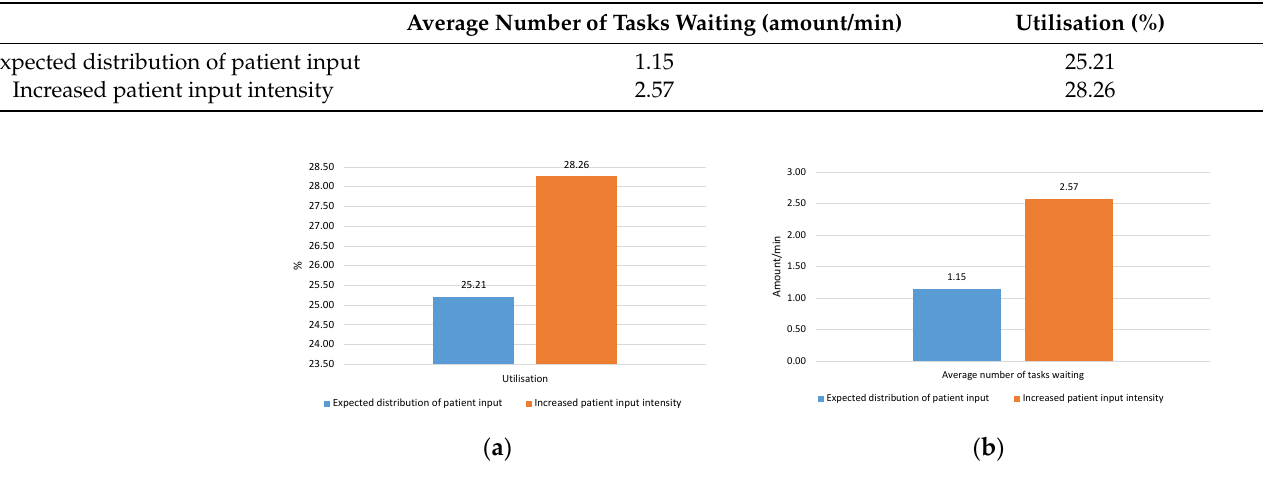
Table 6. Results of simulation experiments carried out for the combined use of surface and space disinfection by AGV.